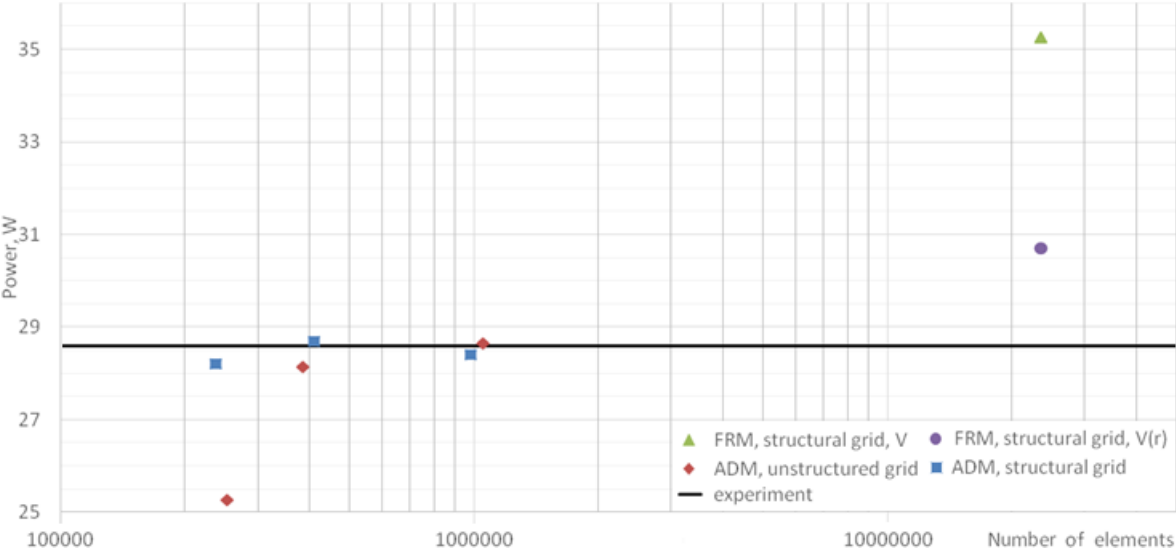
Figure 3: Comparison of the power coeflcient from the experiment (continuous line), ADM (squares), and FRM (triangles, circles), TSR =